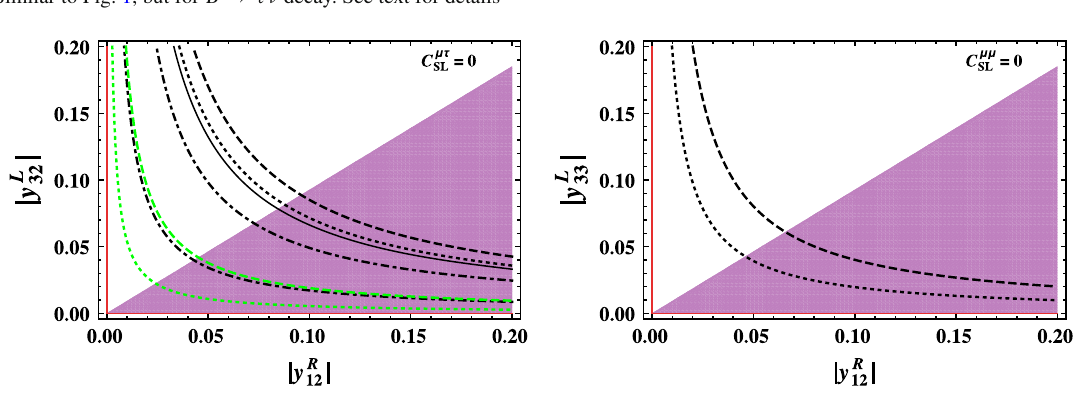
τμ | for Fig. 2 (right). Unlike B → μ ¯ ν decay, on | C SL